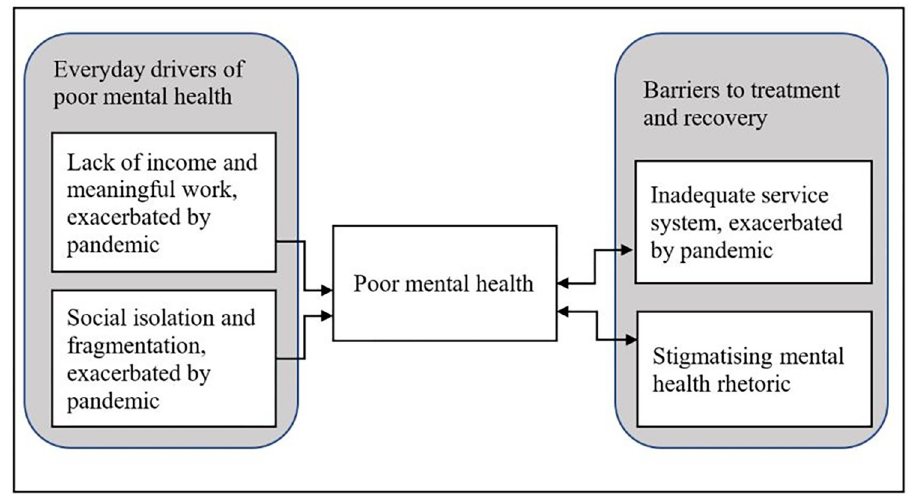
Fig 1. Key themes exacerbated during the COVID-19 pandemic—Everyday drivers of poor mental health and barriers to treatment and recovery.